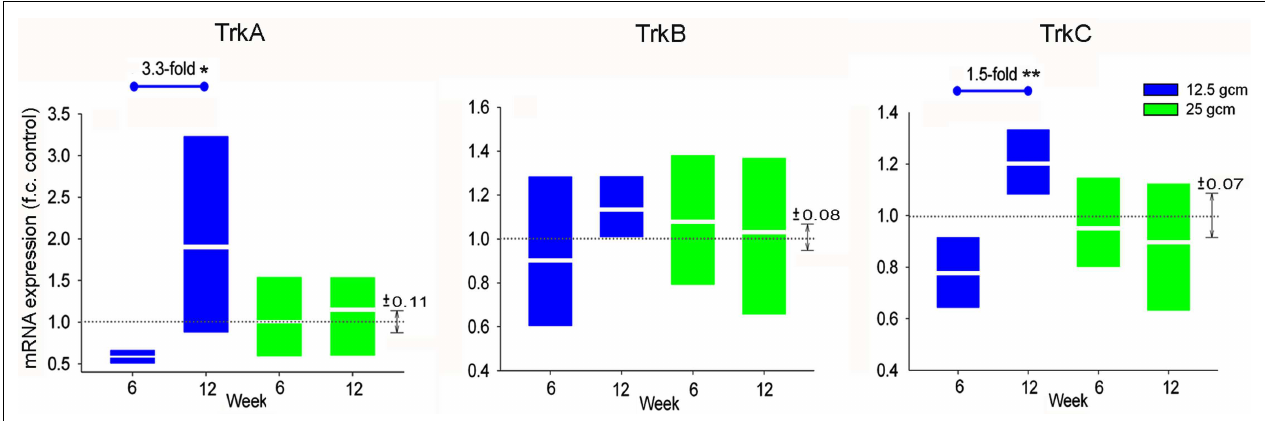
points in all figures. X axis denotes weeks post injury.White lines in box-plots indicate group mean. Dotted gray lines indicate expression level of controls (normalized to 1), with ± SEM indicated by the vertical arrows at right end of the control line. # p < 0.05 from control. * p < 0.05, ** p < 0.01, *** p < 0.001.